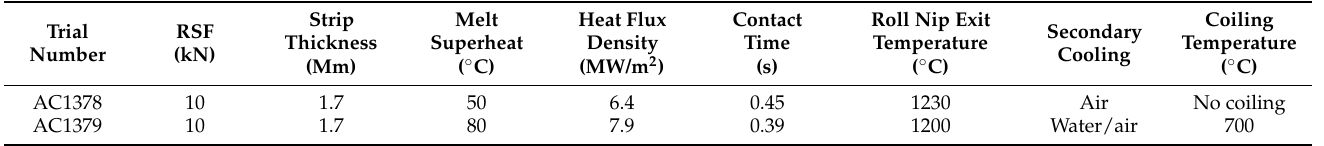
Table 2. Casting parameters of the cast trials AC1378 and